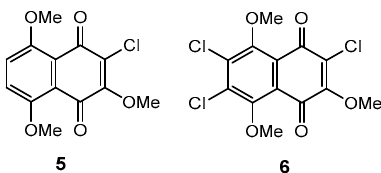
Figure 1. Starting derivatives of 5,8-dimethoxy-1,4-naphthoquinone.